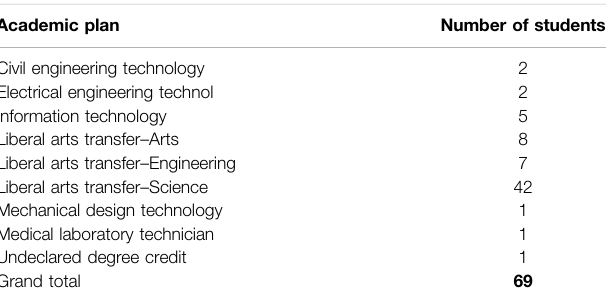
TABLE 3| Inspire Scholars Program participant academic plan in their fi rst term in the